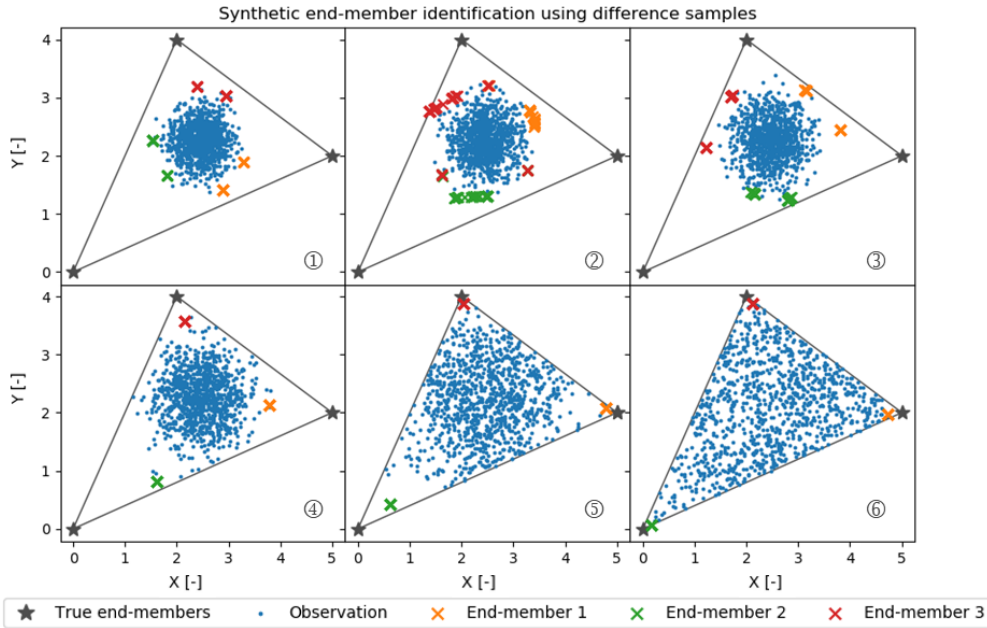
Figure 8. Synthetic random mixture (blue dots) generated by three fixed true end-members (gray stars). All cases (1 to 6) have the same number of samples (1000 samples) and are normally distributed around the inner center of the gray triangle. From case 1 to 6, the mixture occupies more of the convex mixing space, as the standard deviation of the normal distribution used to generate those synthetic points increases.